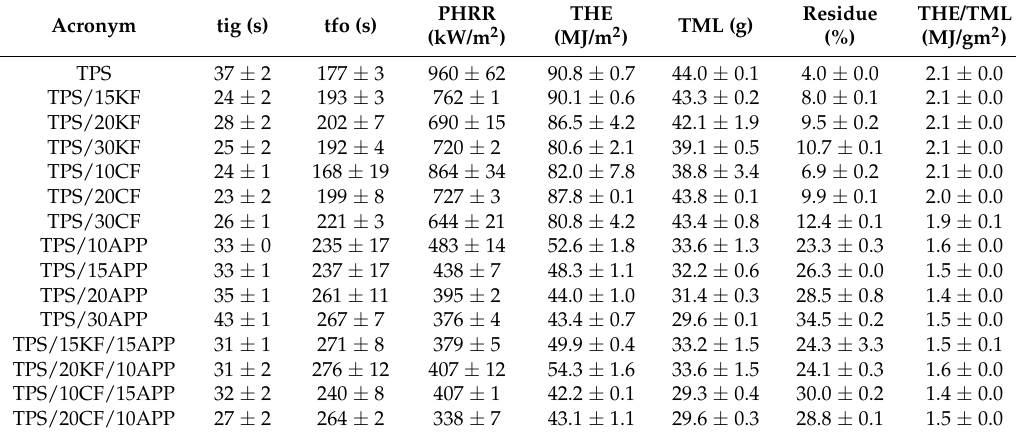
Table 5. Cone calorimeter results of investigated TPS